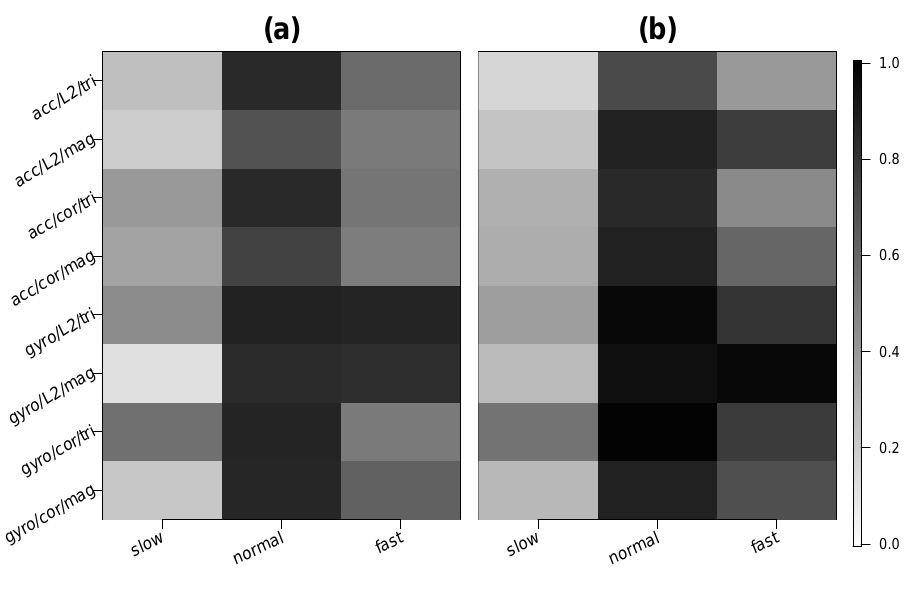
Figure 5. Average sensitivity across subjects for the test data collected in Step 3 (walking at different speeds). Panel ( a ) corresponds to the front pocket phone and Panel ( b ) to the back pocket phone. See Figure 4 for